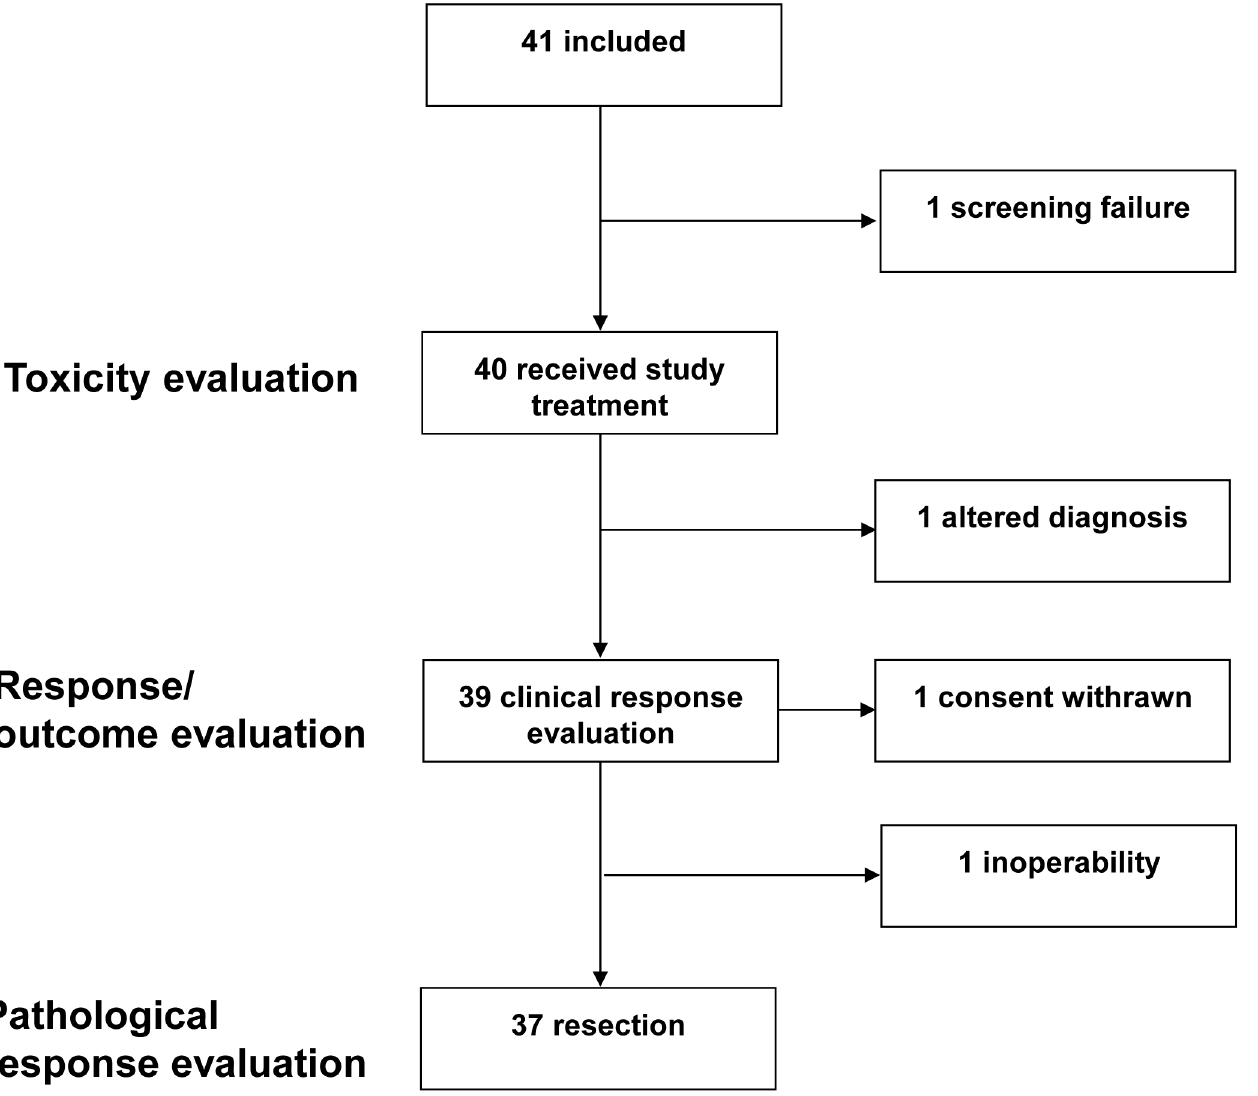
Fig 1. Participant diagram. Paricipant diagram describing patients analyzed in the INN-06